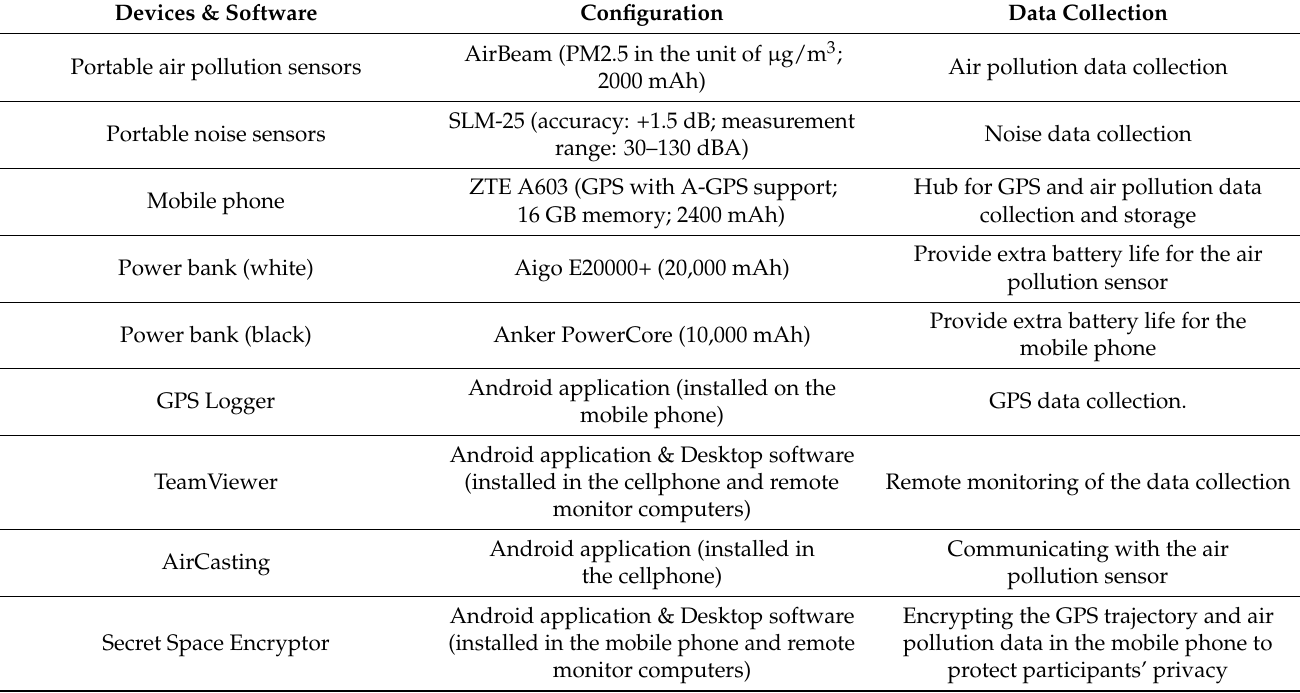
Table 1. The configuration and settings of the portable devices and